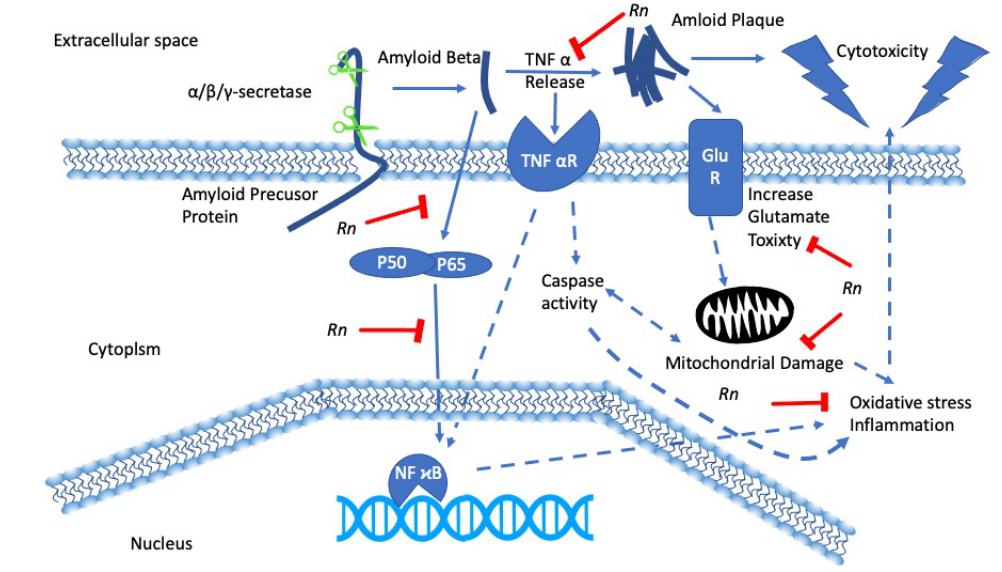
Figure 1. Rhinacanthus nasutus (Rn) and its protective effects in pathways involved in neurodegenerative diseases. Rn inhibits tumor necrosis factor alpha (TNF α ) release thus preventing its interaction with the TNF α receptor (TNF α R). Rn also prevents nuclear factor kappa-light-chain-enhancer of activated B cells (NF- κ B) activation, which in turn leads a reduction in oxidative